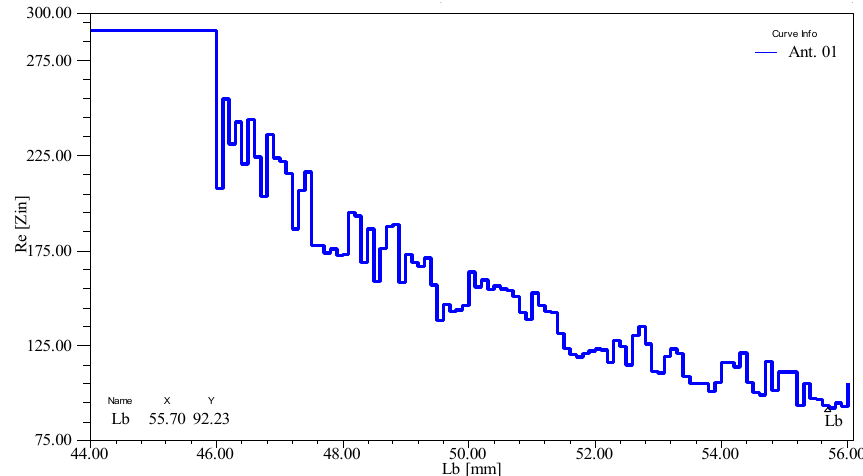
Figure 6. VSWR (Voltage Standing Wave Ratio) of Slot antenna 1 at 2450 MHz versus Lb (mm).